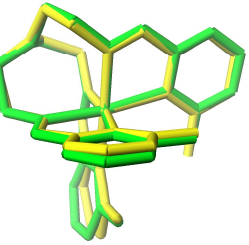
Figure 9. Superimposed structures of HS (green) and LS (yellow) [Fetren(6-MePy)3](PF6)2. Note that the yellow LS form has shorter Fe-N bond distances.